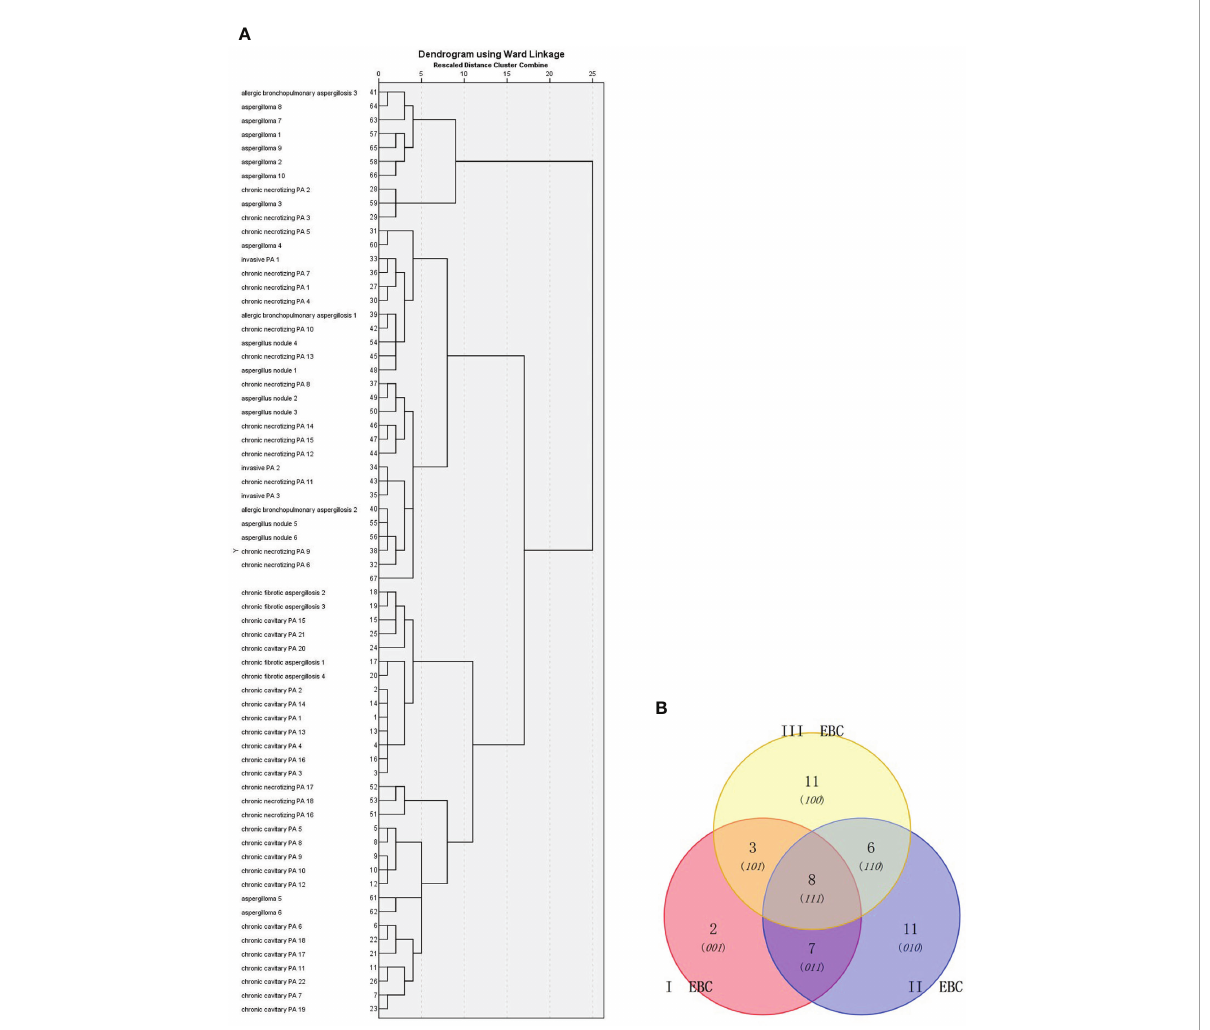
FIGURE 4 Cluster analysis of: (A) 66 PA patients based on Ward chain; and (B) Venn diagram analysis of the EBC metabolites identi fi ed from these patients. I EBC : Table 2 (26, 27). II EBC: Table 2 (29-35, 38,40- 42). III EBC: Table 2 (1, 4, 7, 9,13,16, 43-47).